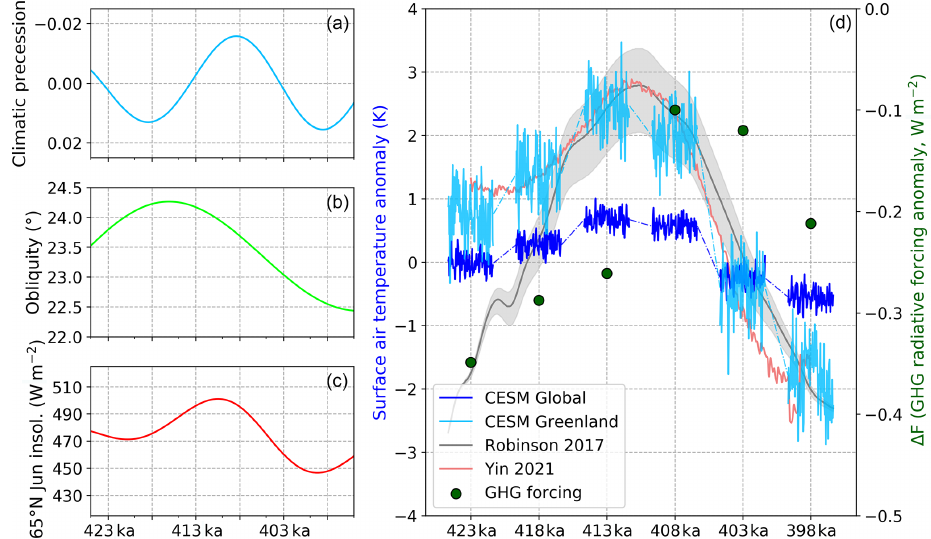
Figure 1. (a–c) Orbital parameters and high-latitude summer insolation during the MIS-11 interglacial. (d) Mean boreal summer global and area-weighted mean Greenland (55–85 ◦ N, 280–350 ◦ E) 2m air temperature anomaly “pseudo-time series” relative to the preindustrial control simulation are given by the dark blue (global) and light blue (Greenland) curves. The pseudo-time series depict seasonal-mean boreal summer (June–July–August; JJA) values from the final 100 years of each simulation; the time x axis is therefore not to scale for these curves and the discontinuities are larger than depicted. The gray curve is the time series of JJA mean temperatures over Greenland from Robinson et al. (2017), which is based on an ensemble of transient, coupled REMBO-SICOPOLIS simulations; the surrounding gray shading represents the 95% confidence interval for temperatures based on this ensemble, while the solid line represents the likeliest estimate. The light red curve is the temperature time series for the Greenland region from the fixed ice LOVECLIM simulation of Yin et al. (2021). The green dots in the right panel indicate the radiative forcing anomaly based on the combined effects of CO 2 , CH 4 , and N 2 O, after IPCC